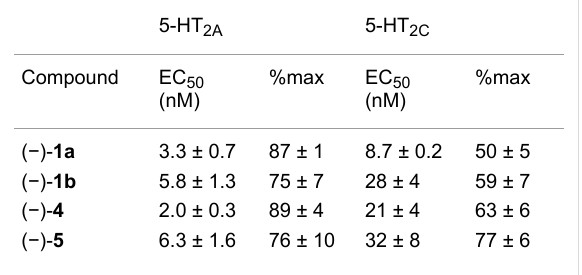
Table 2: Potency and percent max values for calcium release at 5-HT 2A and 5-HT 2C receptors. All values represent mean and SEM from at least three independent